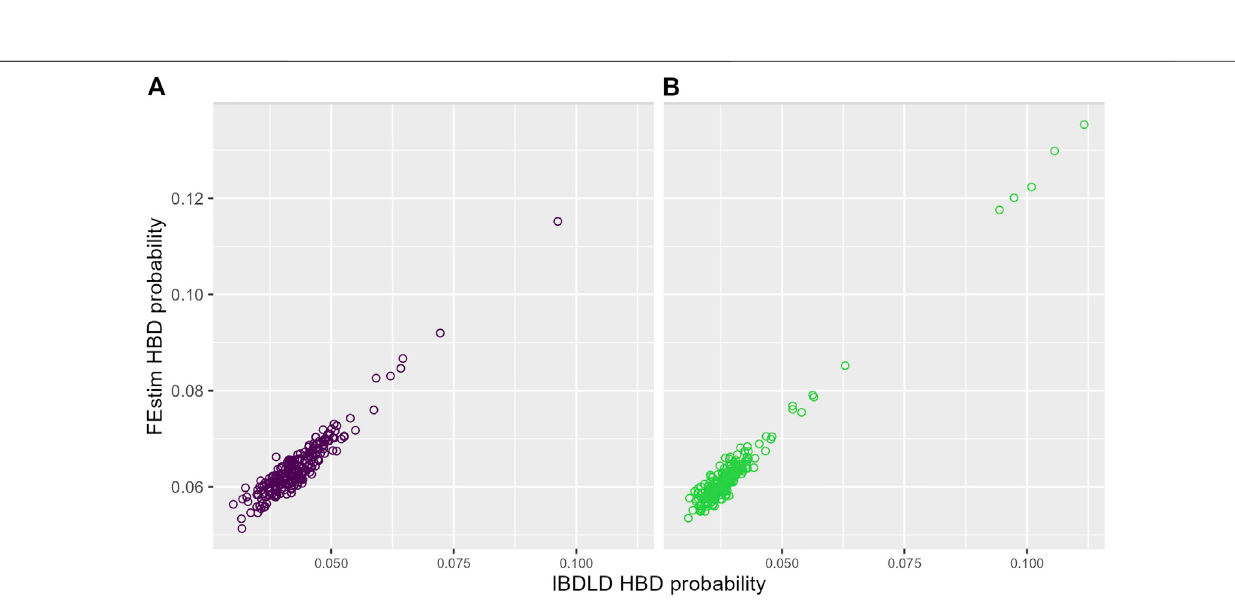
Frontiers in Genetics |